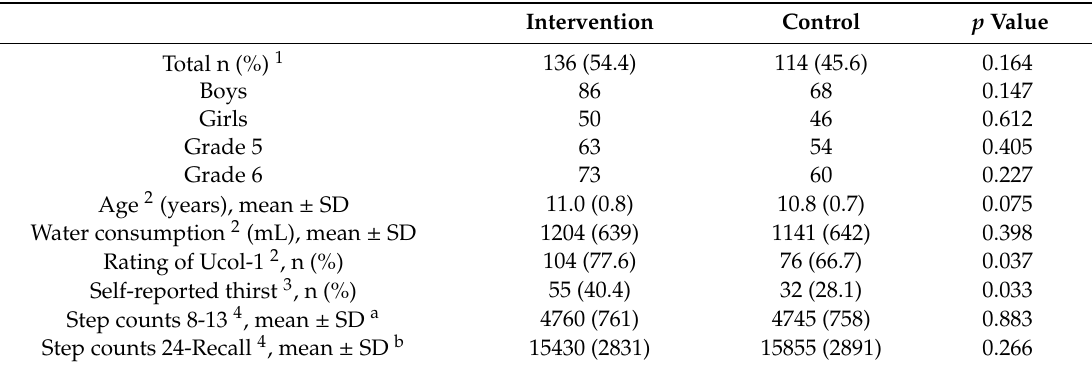
Table 1. Sample characteristics ( n =